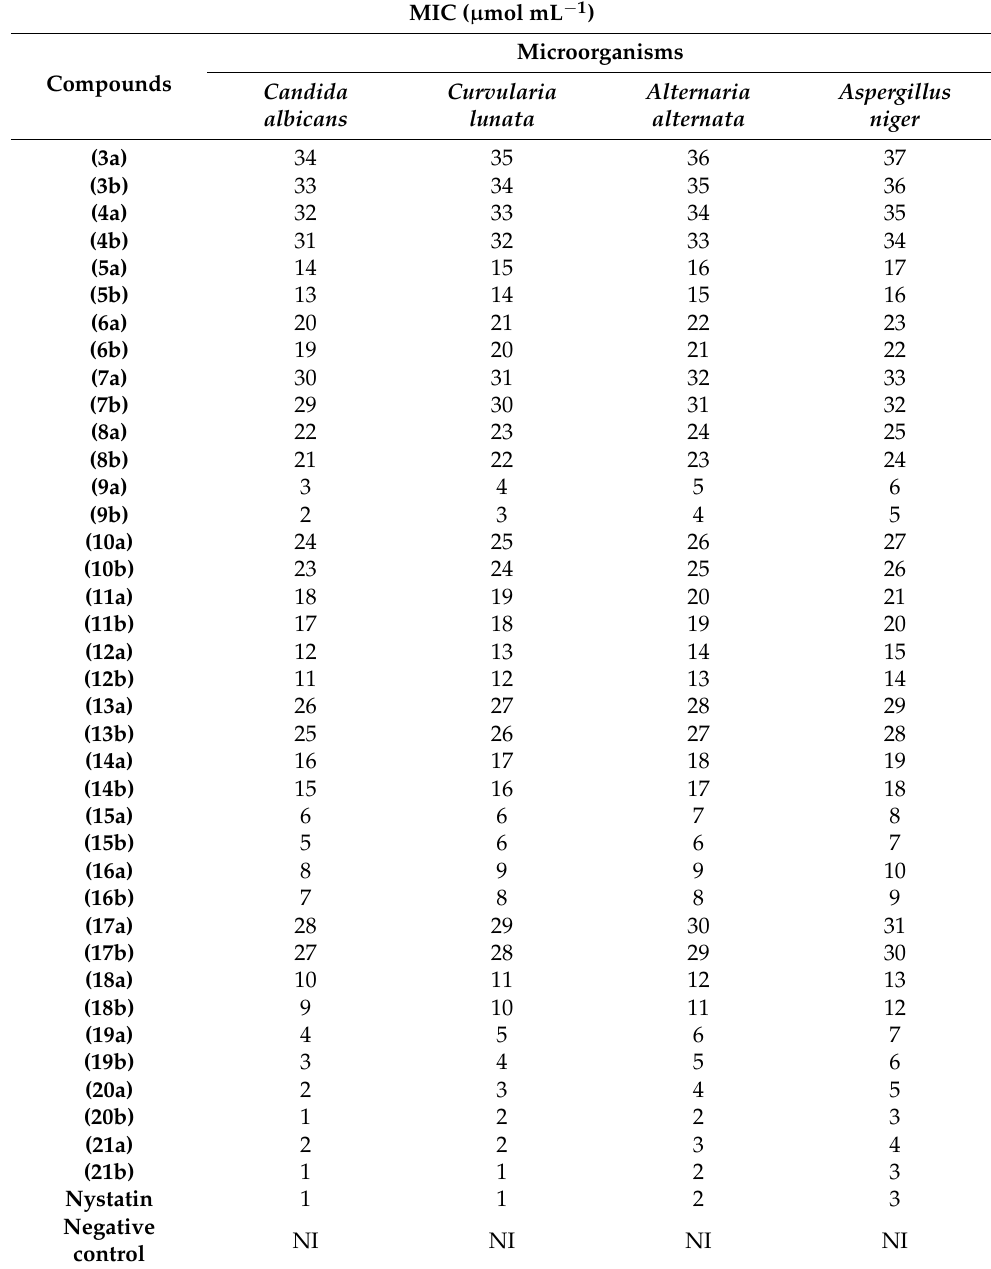
Table 2. A minimum inhibitory concentration of the compounds against